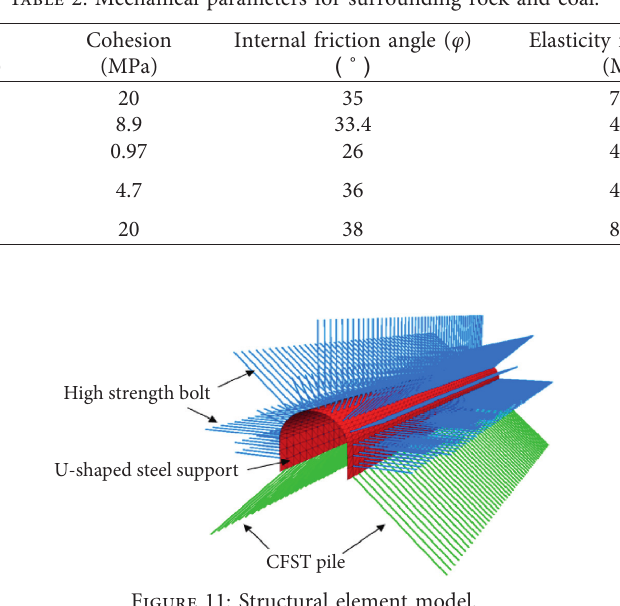
Table 2: Mechanical parameters for surrounding rock and coal.